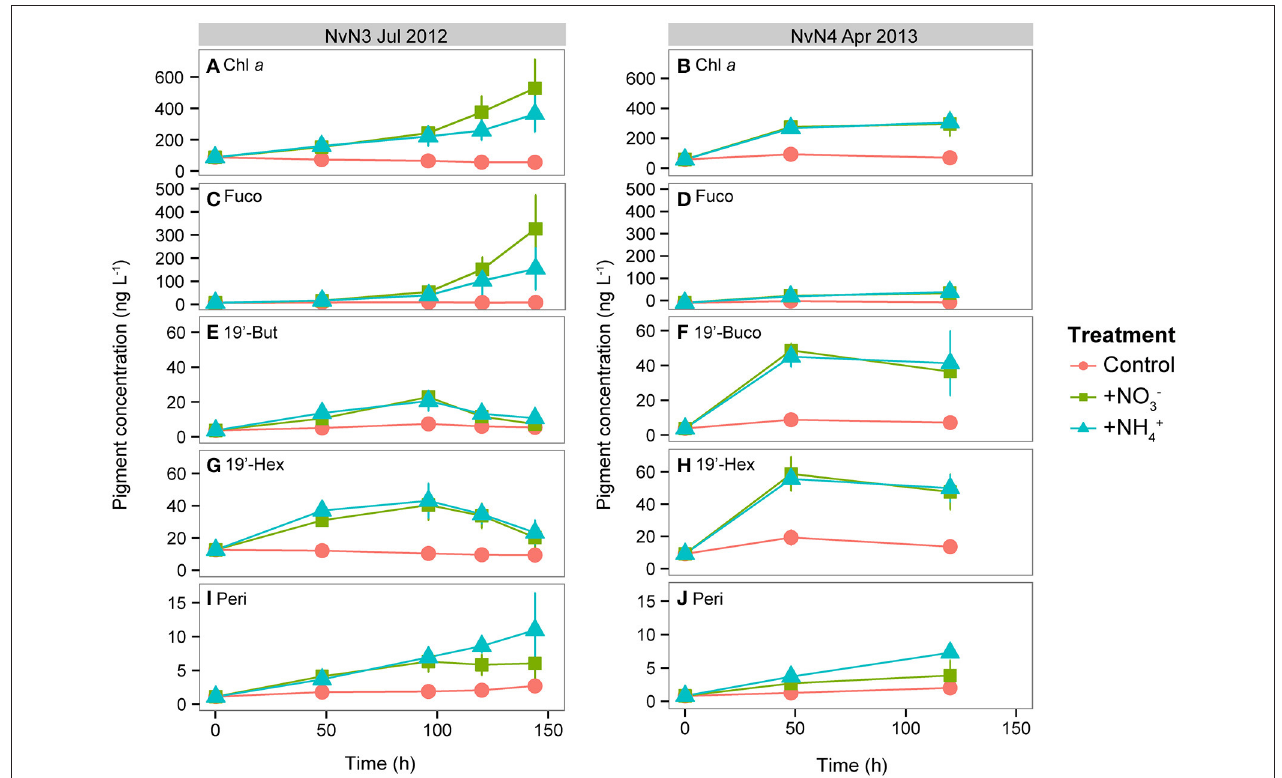
FIGURE 3 | Photosynthetic pigment concentrations (ng L − 1 ) measured during July 2012 and April 2013 from time 0 to end of experiment (120 or 144h): (A,B) Chl a , (C,D) fucoxanthin (Fuco), (E,F) 19 ′ -butanoyloxyfucoxanthin (19 ′ -But), (G,H) 19 ′ -hexanoyloxyfucoxanthin (19 ′ -Hex), (I,J) peridinin (Peri). Note differences in y-axis scales. Line colors indicate different treatments: Control, + NO − 3 , and + NH + 4 . Data points and whiskers indicate means and standard deviations of triplicate